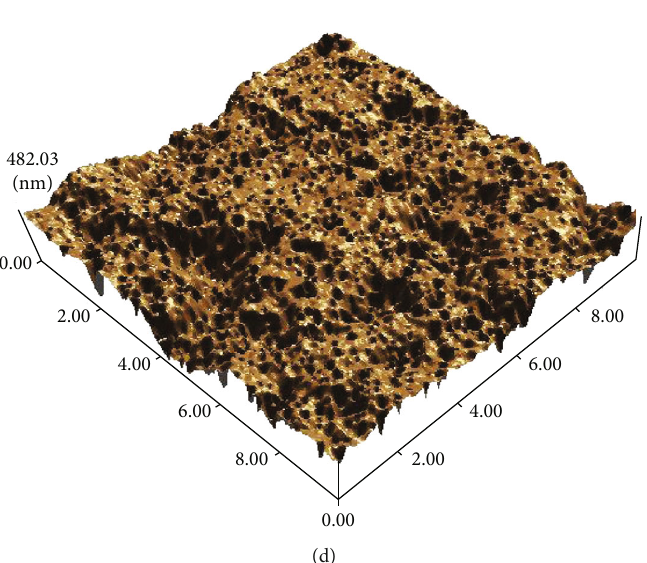
Figure 5: AFM surface topography image PESVP membranes: (a) PESVP0-1; (b) PESVP1-1; (c) PESVP2-1; (d)